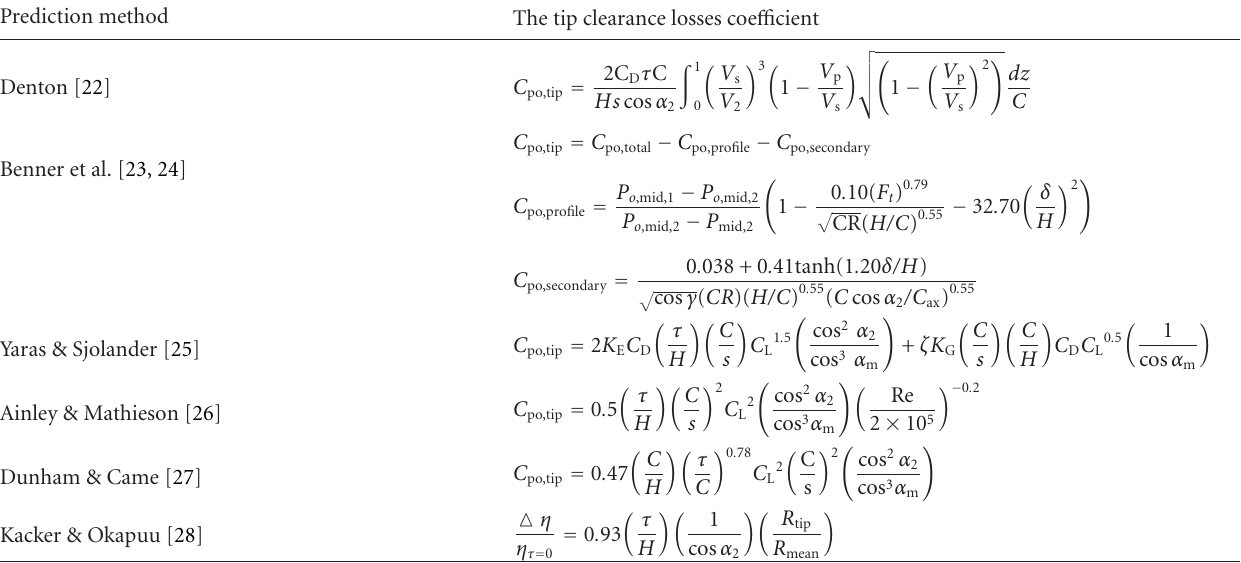
Table 3: Empirical correlations of the tip clearance losses. Prediction method The tip clearance losses coe ffi